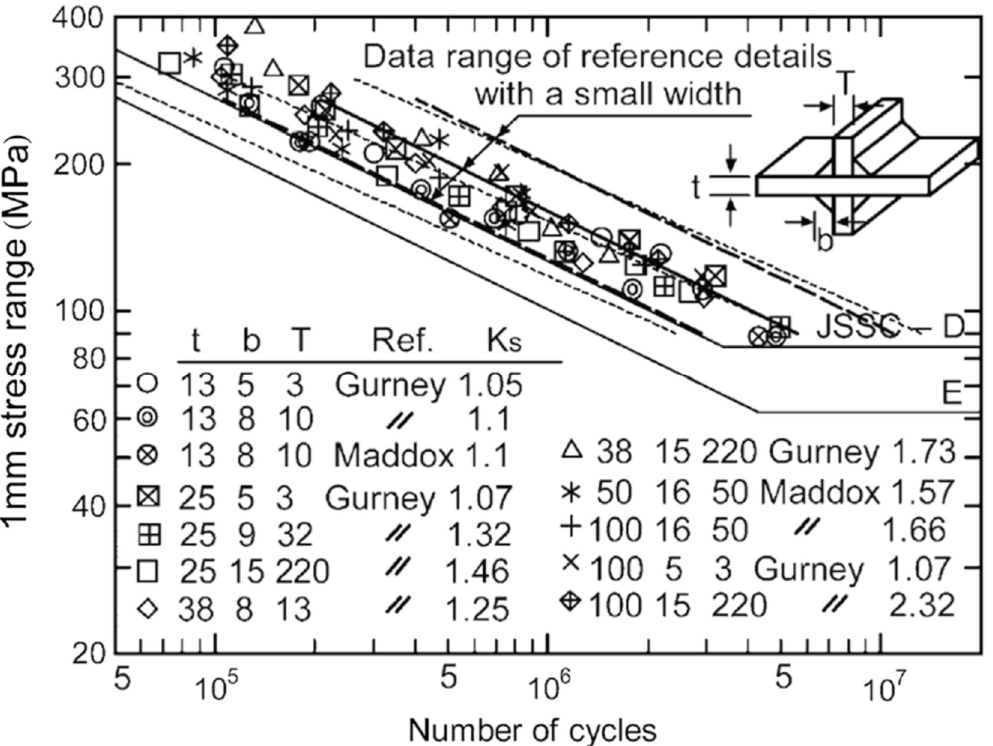
Figure 14. Structural stress–life curve of cruciform welded joint with various geometries [74]. Reprinted with permission from ref. [74]. Copyright 2004 Elsevier.